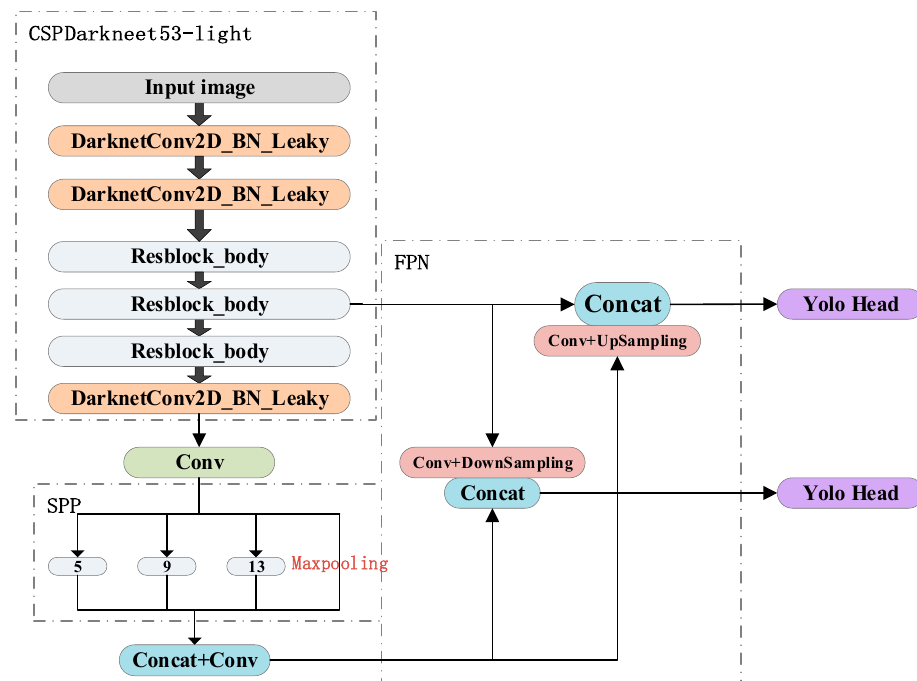
Figure 6. Yolo-V4Light network architecture.